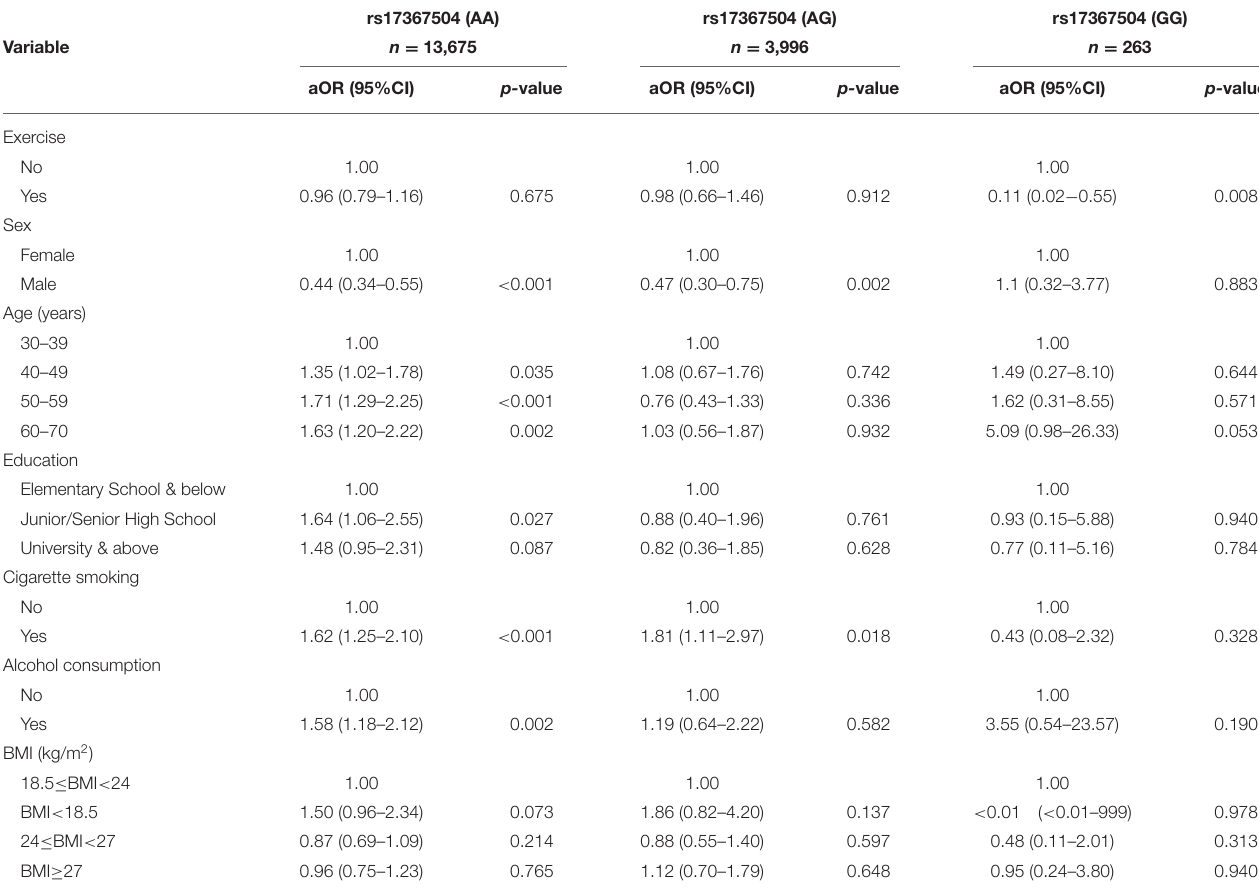
TABLE 4 | Association of MDD with exercise stratified by MTHFR rs17367504